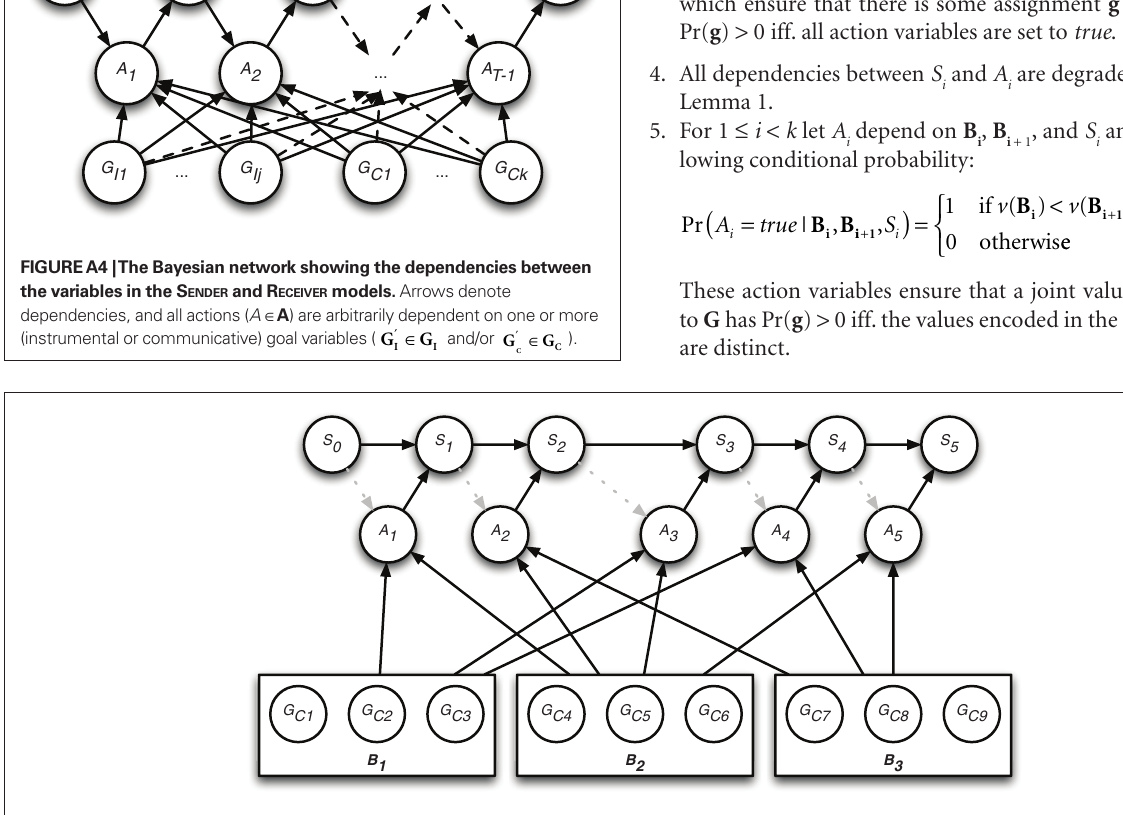
Figure A5 | An example of a Clique instance with k = 3 and | V | = 6 reduced to a r eceiver instance. Here Boolean goal variables in the blocks encode vertices from the C lique instance, actions encode “ C lique -rules” and states conjoin the rules. Degraded dependencies – i.e., those that have their conditional probabilities set such that they do not influence the Bayesian inference – are depicted by dotted arrows.